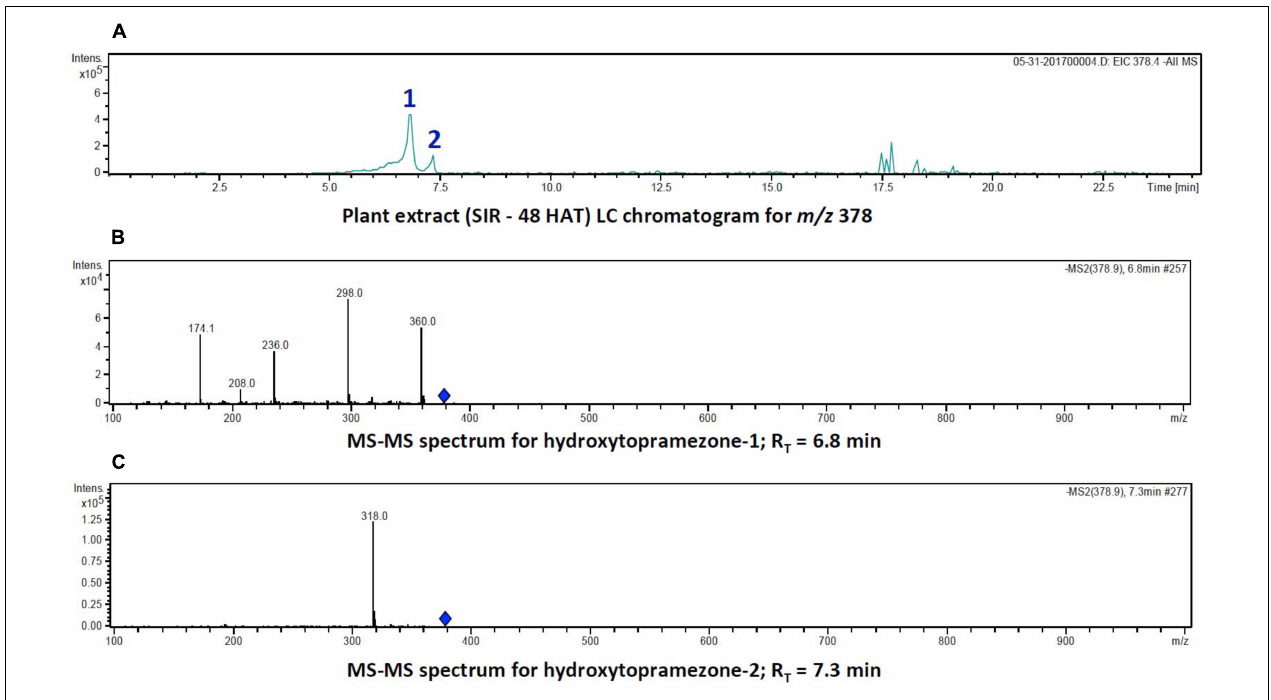
FIGURE 5 | Identification of hydroxytopramezone-1 and hydroxytopramezone-2 metabolites formed in treated leaves of multiple herbicide-resistant waterhemp (SIR) 48 HAT using low-resolution LC-MS. The third- and fourth-youngest leaves from waterhemp and maize plants (10–12 cm tall) were treated with 60 × 0.33 µ L droplets (20 µ L total) of a 1.5 mM topramezone solution, including 0.1% (v/v) Tween 20 as a leaf wetting agent, using a glass syringe. Only the treated leaves were harvested from each plant (48 HAT), extracted and partially purified by SPE chromatography, then analyzed by LC-MS (low resolution) as described in Section “Materials and Methods.” (A) LC analysis of compounds with m/z of 378 (M + 16). (B) LC-MS/MS spectrum of putative hydroxytopramezone-1 ( R T = 6.8 min in A ). (C) LC-MS/MS spectrum of putative hydroxytopramezone-2 ( R T = 7.3 min in A